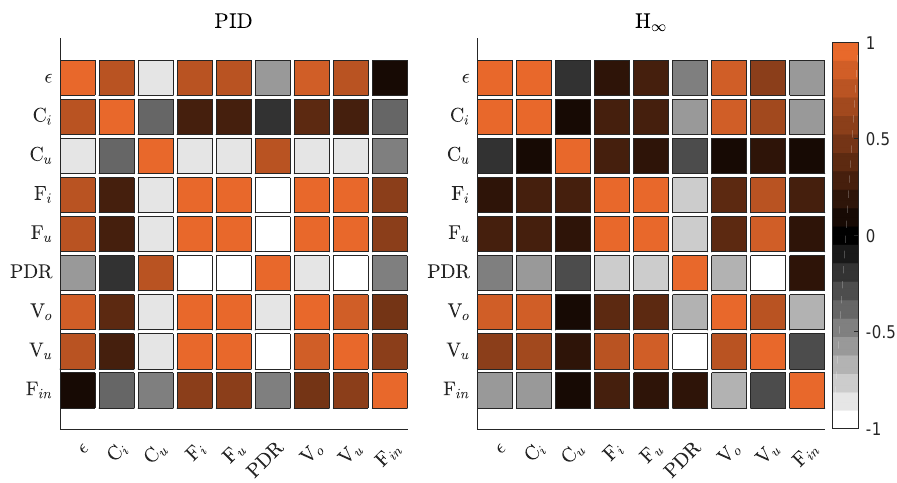
Figure 6. Correlation matrix of system parameters from 2080 to 2550 s, with respect to the PID and H ∞ control solution. A numerical version is attached in the appendix, see Figure